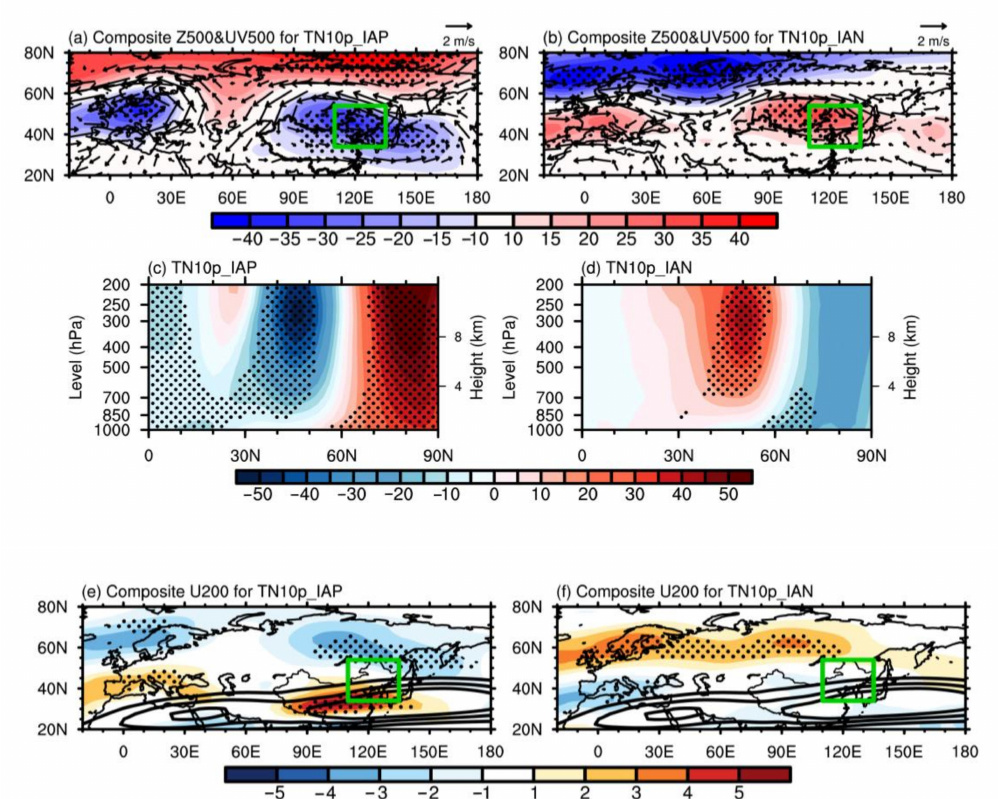
Figure 6. Composite maps of ( a ) height anomalies (shaded, unit: gpm) and wind anomalies (vector, unit: m/s) at 500 hPa in TN10p_IAP years, ( c ) The latitude-pressure sections of geopotential height anomalies (unit: gpm) along 120 ◦ E in TN10p_IAP years. ( e ) U200 anomalies (shaded, unit: m/s) and Westerly jet in climate (black line, unit: m/s). ( b , d , f ) same as ( a , c , e ), but for TN10p_IAN years. The dotted region indicates significance of shading at the 95% level from the t